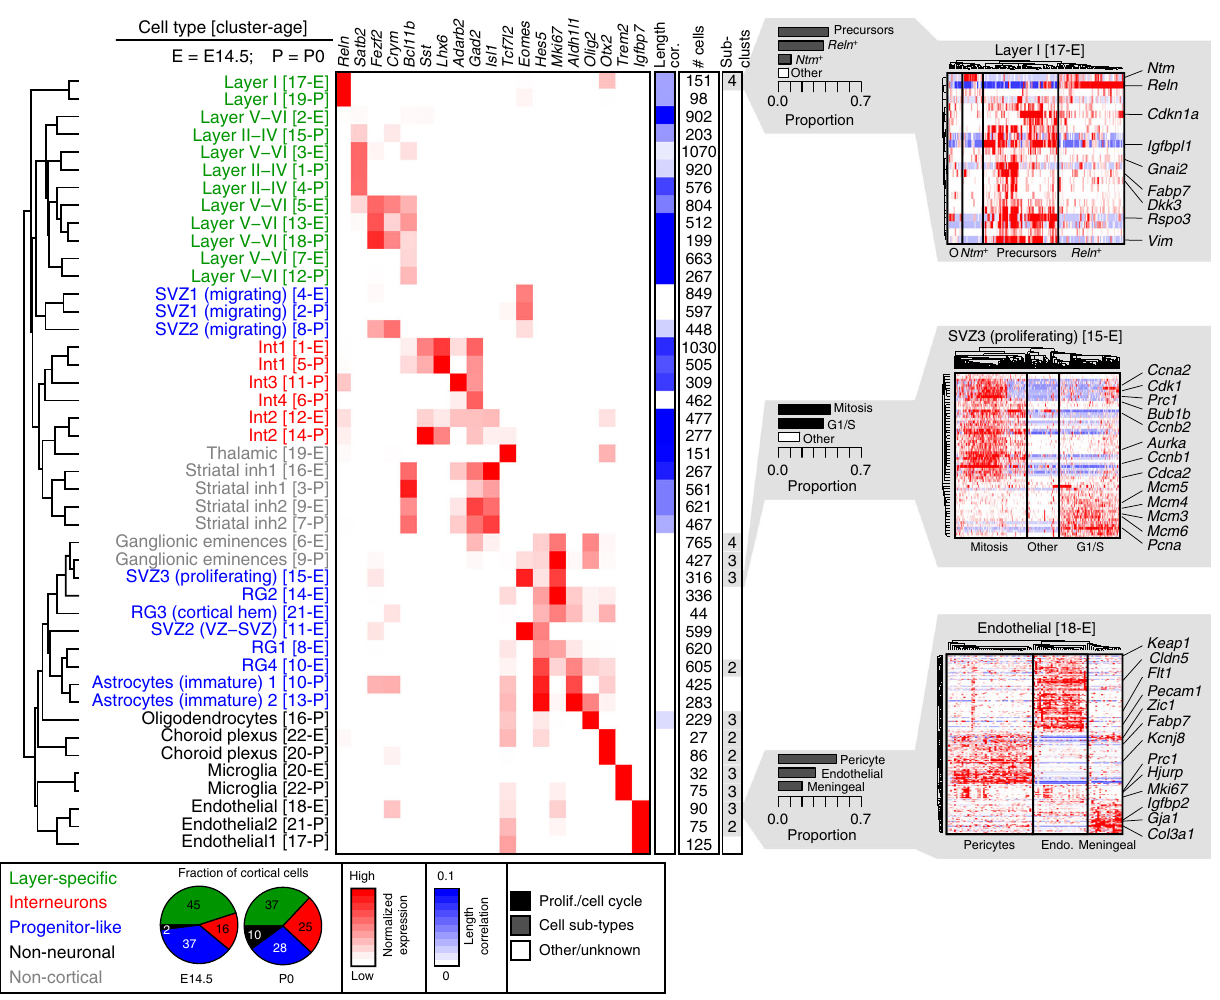
Fig. 2 Characterization of cell types in the developing cortex. Cell types were grouped into categories (colored), based on their functional identity and transcriptional similarity (Pearson correlation distances, dendrogram). Correlation of expression with gene length provided on a scale of white to blue. Total number of cells identi fi ed for each cluster is provided. Fractional proportions of cortical cells, averaged across all biological replicates, is depicted as a pie chart; non-cortical cells were excluded. Number of cellular sub-clusters for each cell type is indicated, as well as three sub-cluster examples. All sub- clusters are fully characterized in Supplementary